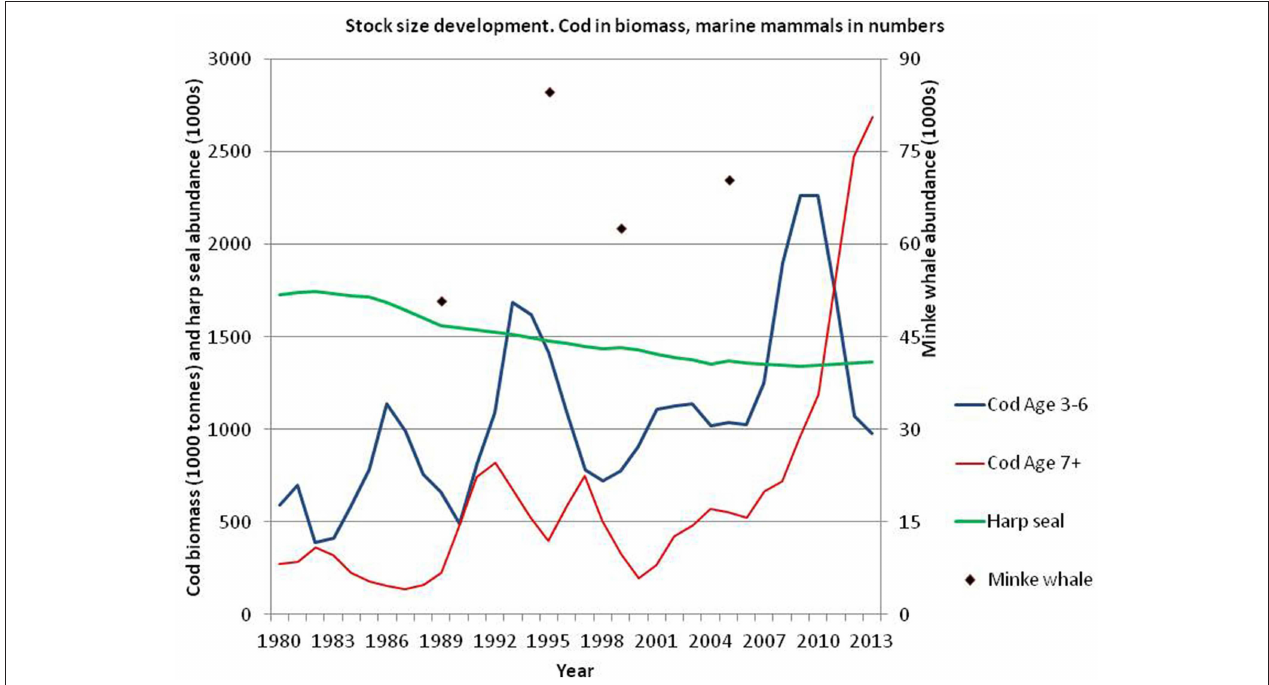
based on stomach content data and a model for gastric evacuation rate, and the consumption is calculated by cod age group (1–11 + ), half-year and three areas in the Barents